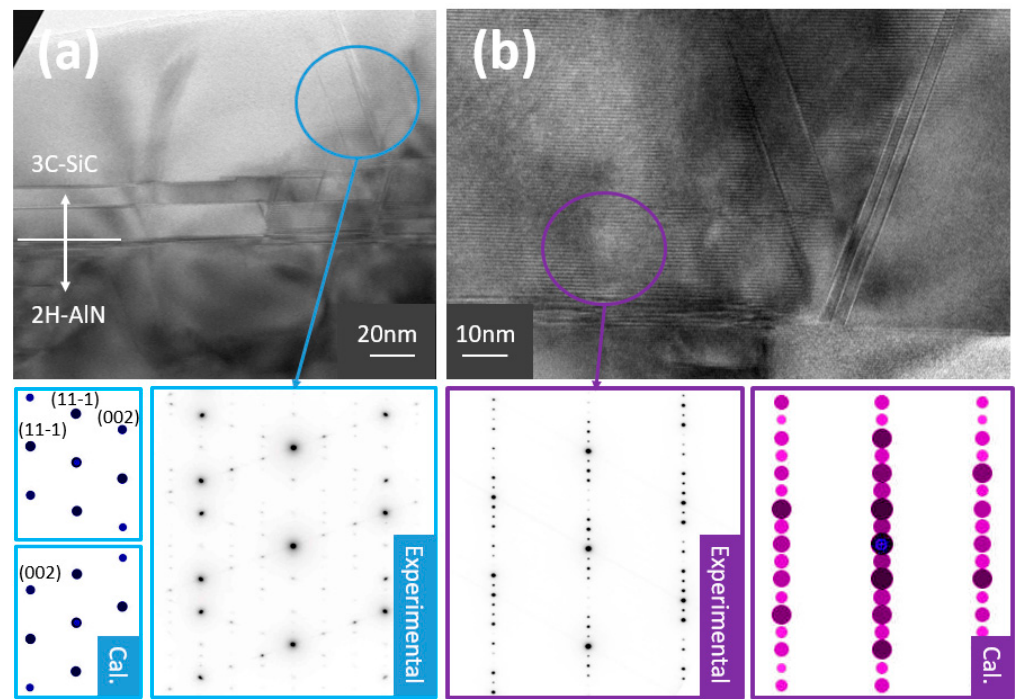
Figure 4. TEM and HRTEM cross-section images recorded on a 3C-SiC/AlN/Si(110) sample: ( a ) large-scale image with experimental and simulated SAED patterns (bottom). ( b ) high magnification image on the interfacial region with experimental and simulated SAED patterns (bottom) showing the presence of 6H-polytype.